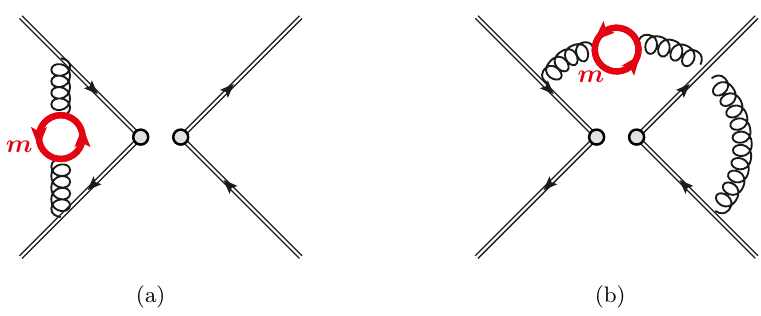
Figure 10 . Corrections from secondary massive quarks to the (c)soft function. Also the mirror diagrams need to be